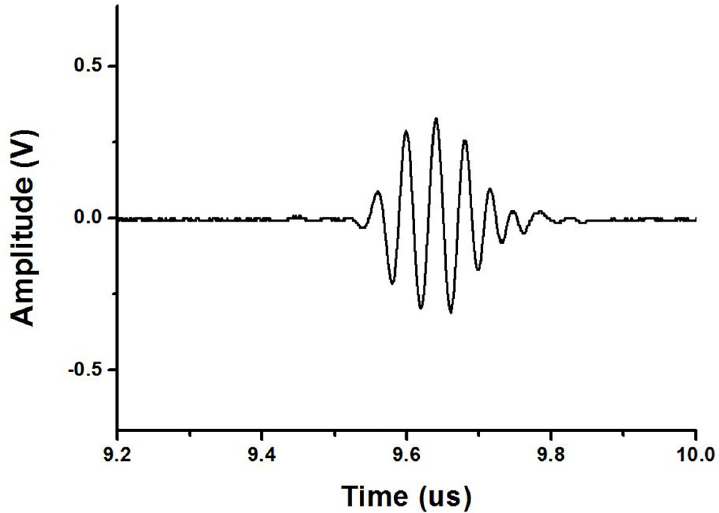
Fig 15. The first echo signal transmitted and received by a high-efficiency and high-voltage class F amplifier and 25-MHz transducers.